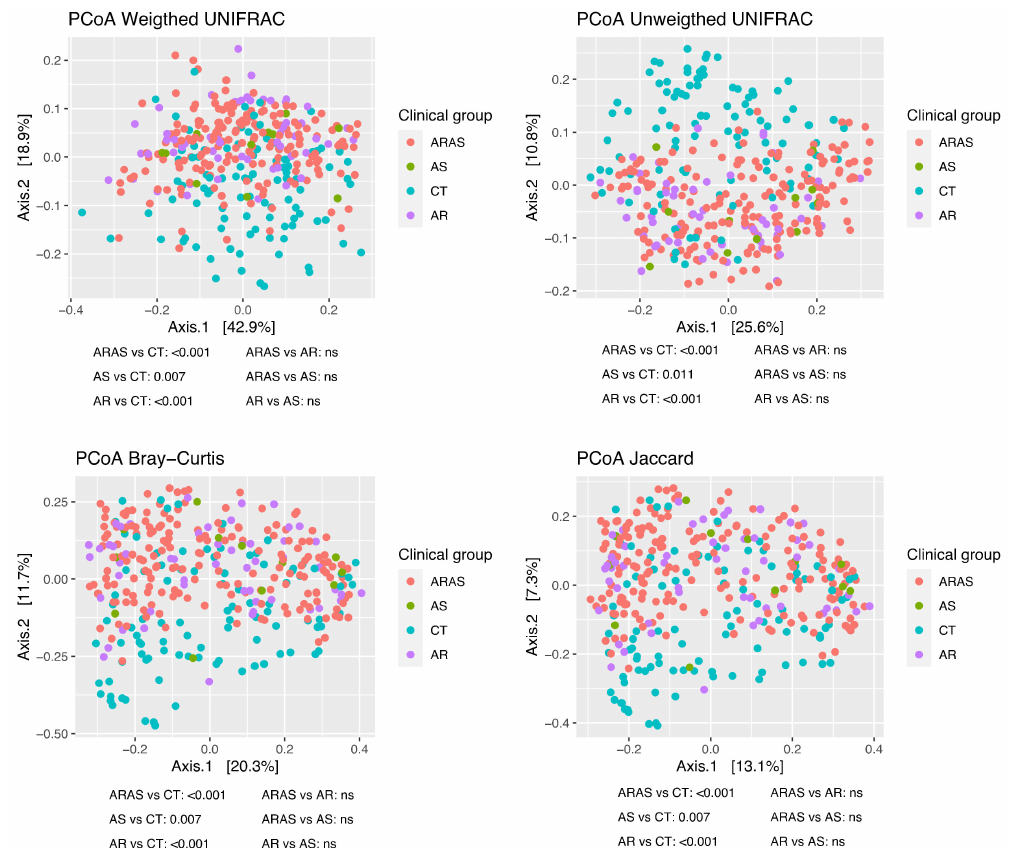
Figure 3. Principal coordinates analysis (PCoA) plots of beta-diversity estimates (Unifrac, Bray–Curtis and Jaccard indices) and statistical significance (adonis test) of the nasal bacteriome of participants with asthma (AS), allergic rhinitis with comorbid asthma (ARAS), allergic rhinitis (AR) and healthy controls (CT). ns = not